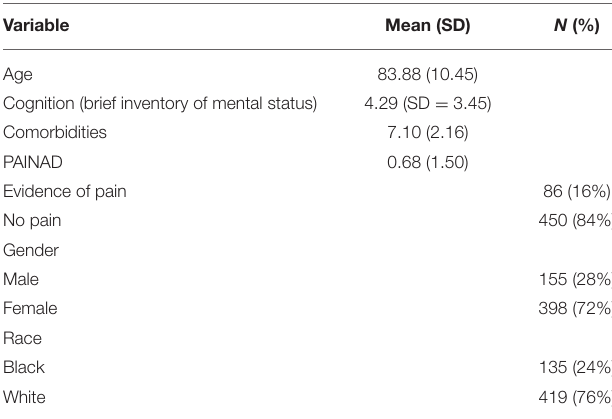
TABLE 1 | Description of